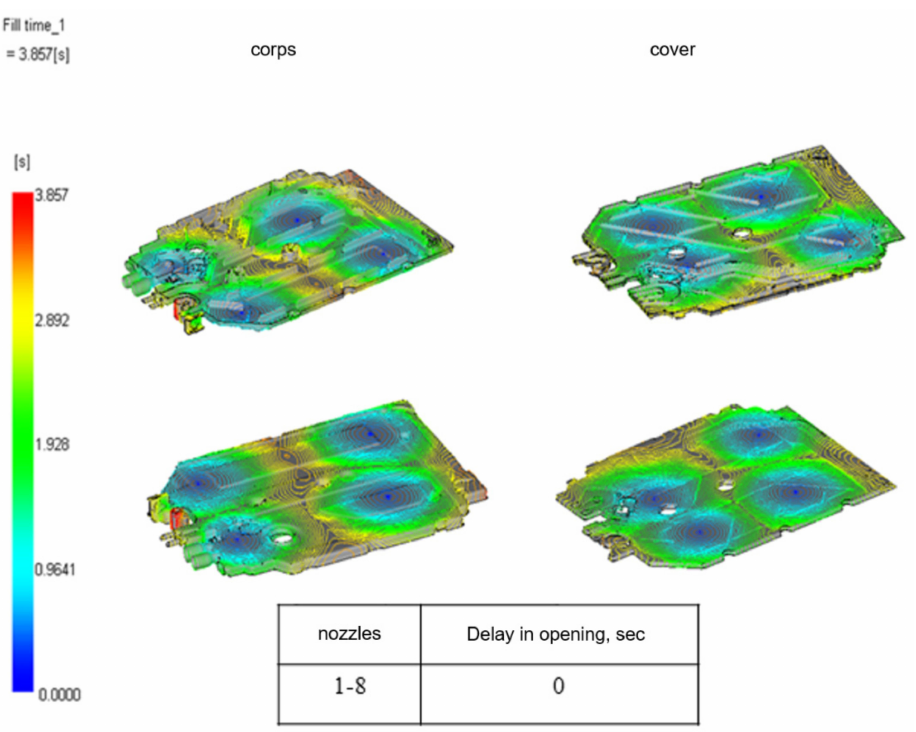
Figure 12. Plastic flow diagrams in the form—visible flow fronts.